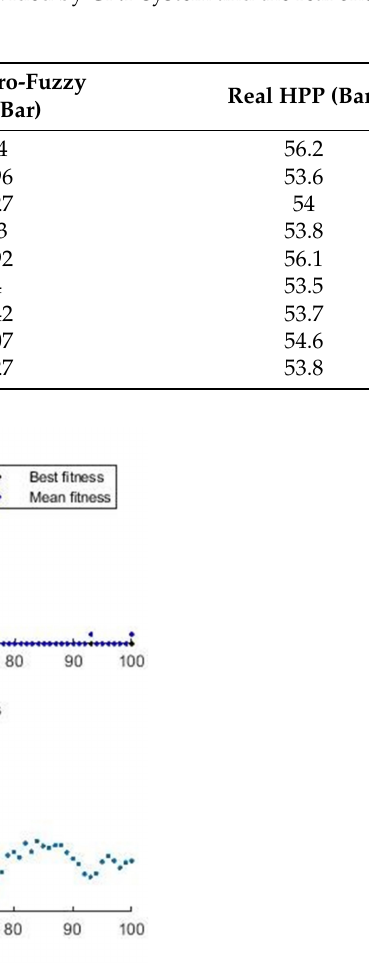
Figure 7. Trend in fitness value and average distances between individuals for feed flow rate as